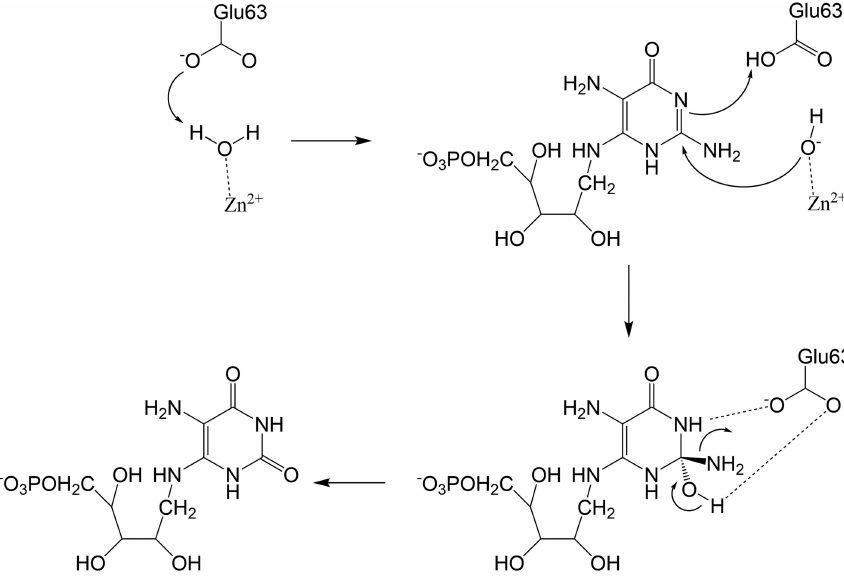
Figure 7 Proposed mechanism of deamination by